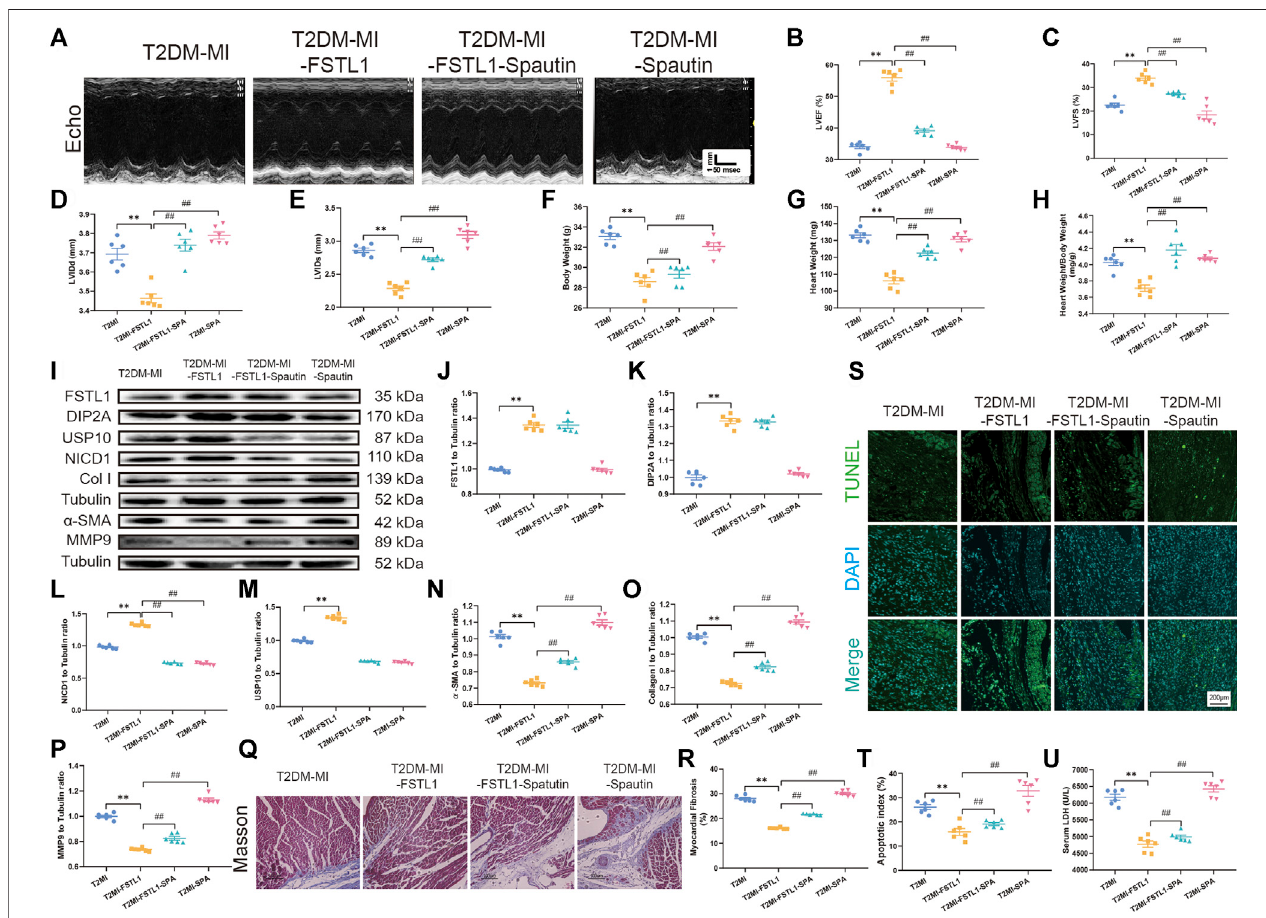
FIGURE 5 | Echocardiographicfunction,levelsofFSTL1andmyocardial fi brosisinT2DMpost-USP10inhibition. (A) RepresentativeM-modeimagesofechocardiography challengedwithMIinjuryinT2DMmicewith/withoutFSTL1treatment; (B) Leftventricularejectionfraction(LVEF); (C) Leftventricularfractionalshortening(LVFS); (D) Leftventricular internal diameter at end-diastole (LVIDd); (E) Left ventricular internal diameter at end-systole (LVIDs); (F) Body weight; (G) Heart weight; (H) Heart weight to body weight ratio; (I) RepresentativeimagesofWesternblotinT2DMmicechallengedwithshamorMIinjurywith/withoutFSTL1treatment; (J) FSTL1level; (K) DIP2Alevel; (L) NICD1level; (M) USP10level; (N) α -SMAlevel; (O) CollagenIlevel; (P) MMP9level; (Q) Cardiacinterstitial fi brosisusingMasson ’ sTrichromestaining; (R) Pooleddataoftheinterstitial fi broticareaof myocardial tissues; (S) Representative images of apoptotic cardiomyocytes; TUNEL: green fl uorescence represents TUNEL positive nuclei; DAPI: blue fl uorescence represents totalcardiomyocytenuclei; (T) Myocardialapoptosiswaspresentedastheapoptoticindex( × 100%);and (U) SerumLDHlevel.TheresultsarepresentedasMean ± SEM, n (cid:2) 6in each group. ** p < 0.01. Scale bar in (Q) was 100 μ m and the scale bar in (R) was 200 μ m.